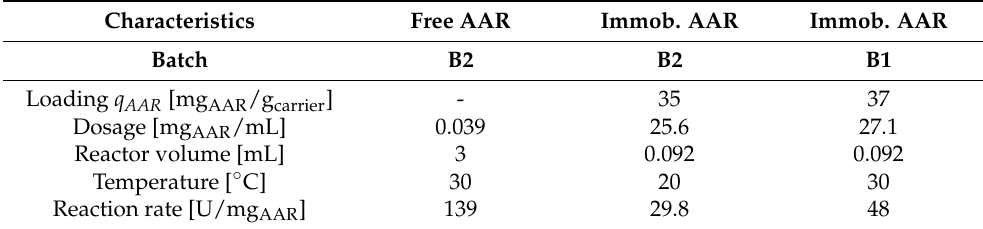
Table 1. Experimental data of enzyme activity tests for free and immobilized amino acid racemase (AAR) on ECF 8309F (56 mg carrier filled in the enzymatic fixed-bed reactor (EFBR)). All reactions were performed at 30 ◦ C and with feed solutions of 20 g/L of L